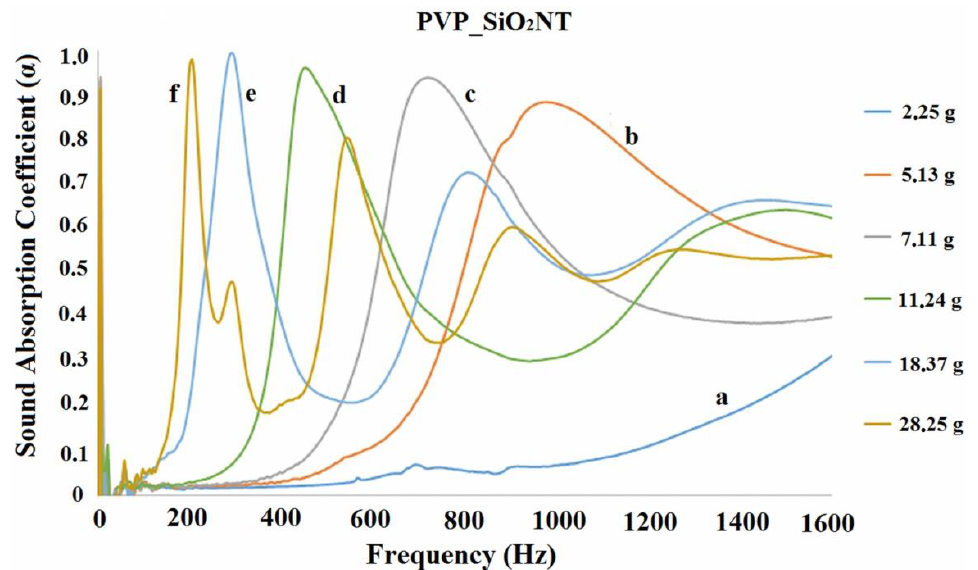
Figure 12. Plots of the sound absorption coefficient as a function of frequency for various PVP_SiO 2 NT disks piles. The a, b, c, d, e and f curves refer, respectively, to samples of total mass 2.25 g, 5.13 g, 7.11 g, 11.24 g, 18.37 g and 28.25 g.